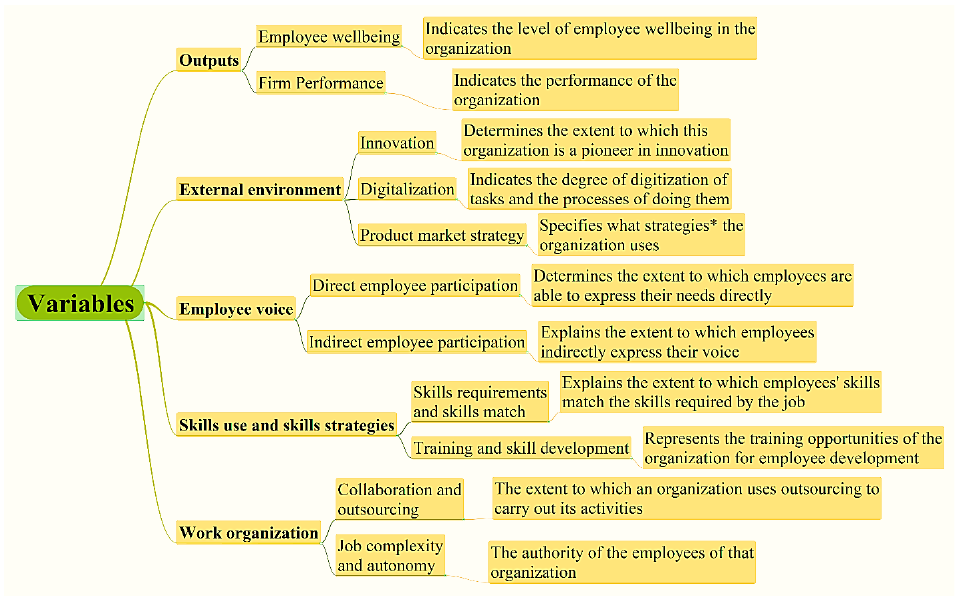
Figure 1. The explanation of the variables. The stared strategies are listed related to product market guideline.